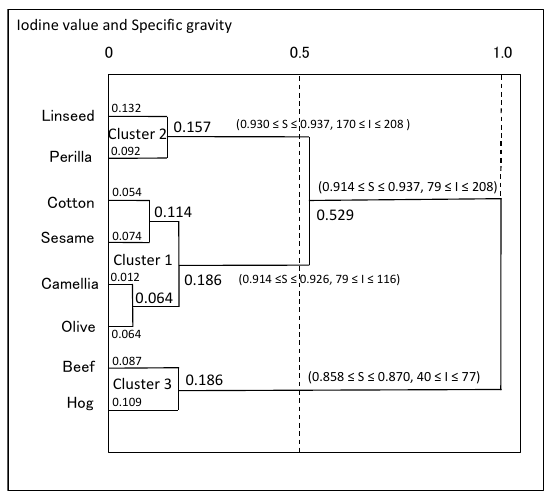
Figure 12. Descriptions using specific gravity and iodine value.